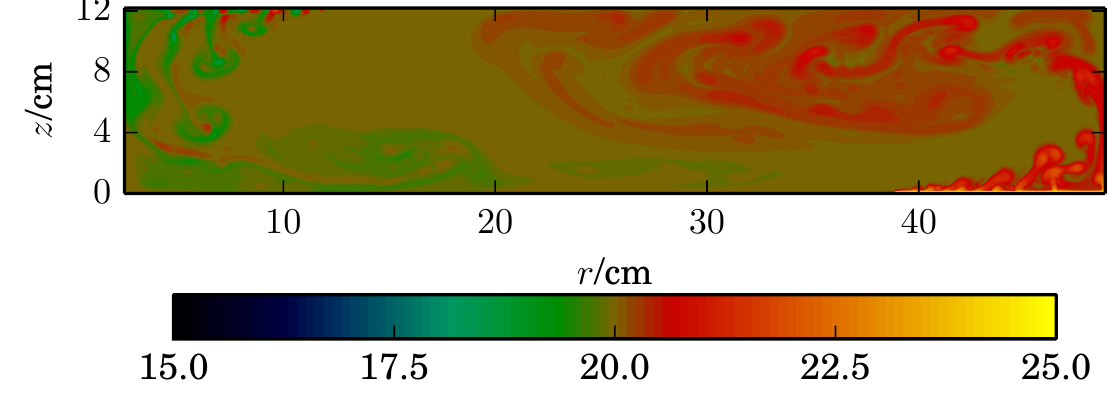
Figure 3. The instantaneous temperature field after 100 s of simulation time for a run with ∆ T = 10 °C, d = 12.2 cm and Ω = 0.001 rad s − 1 . Plumes above the heat source and below the heat sink are resolved. · Supplementary Material movie S1 animates the first 250 s of this